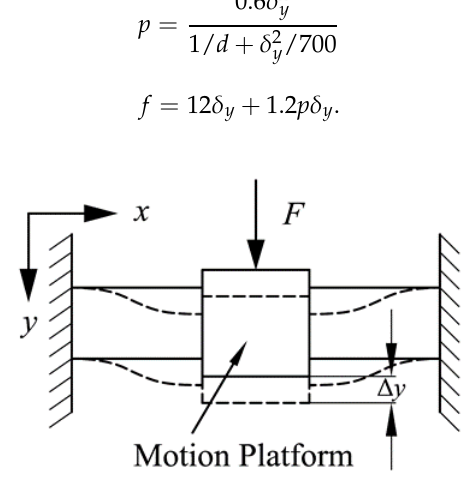
Figure 8. Deformation of the compound parallelogram mechanism.